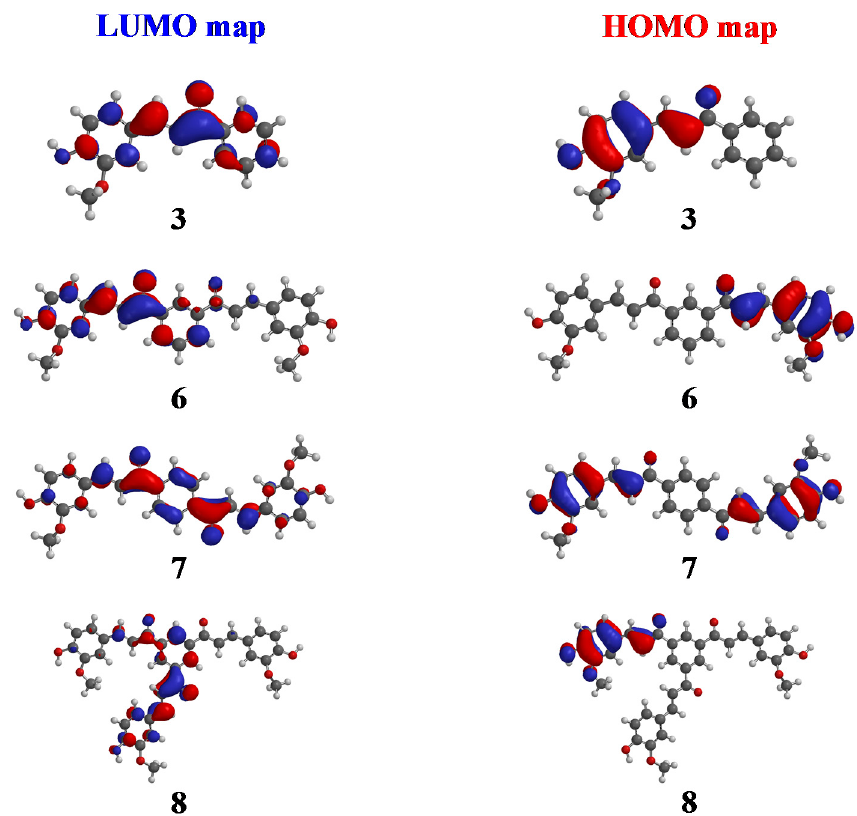
Figure 3. LUMO and HOMO maps of chalcones derivatives 3 and 6 – 8 .